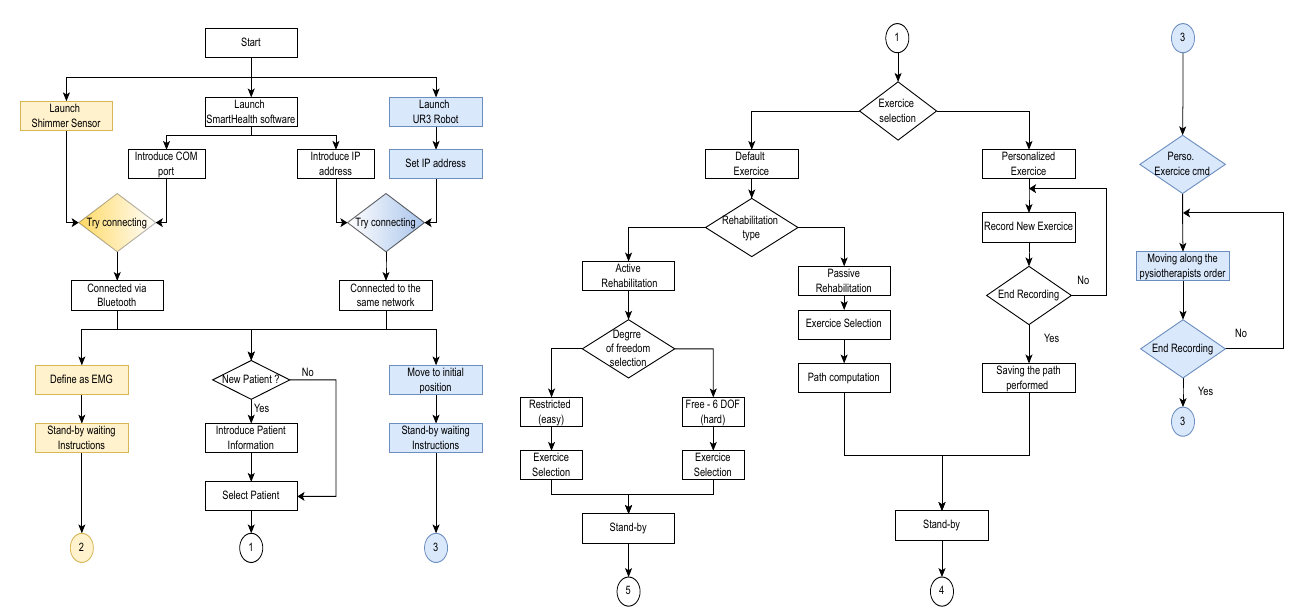
Figure 3. Operation flowchart for the remote control system, part 1. White color defines the flowchart in the software. Blue color defines the flowchart in the robot. Yellow color defines the flowchart in the shimmer